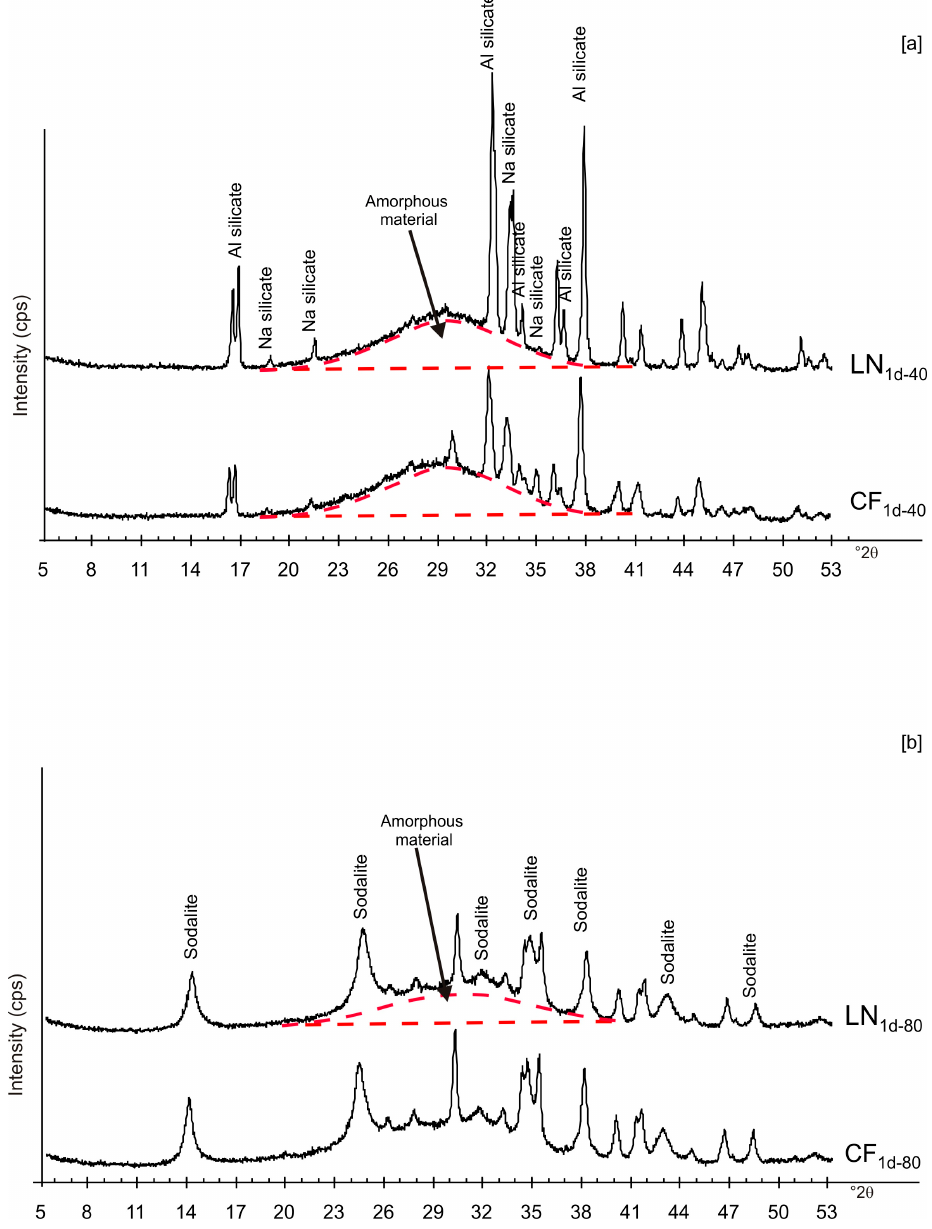
Figure 2. X-ray patterns of CF and LN samples immediately after drying at 40 ( a ) and 80 °C ( b ).